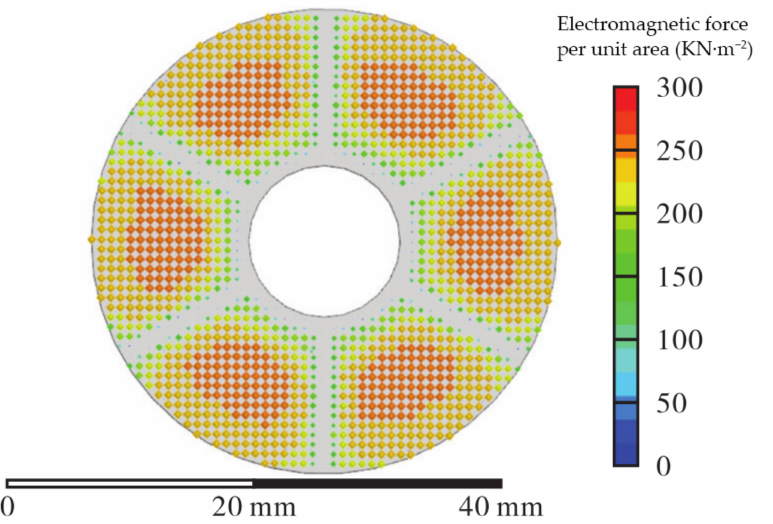
Figure 13. Distribution of Static electromagnetic force.